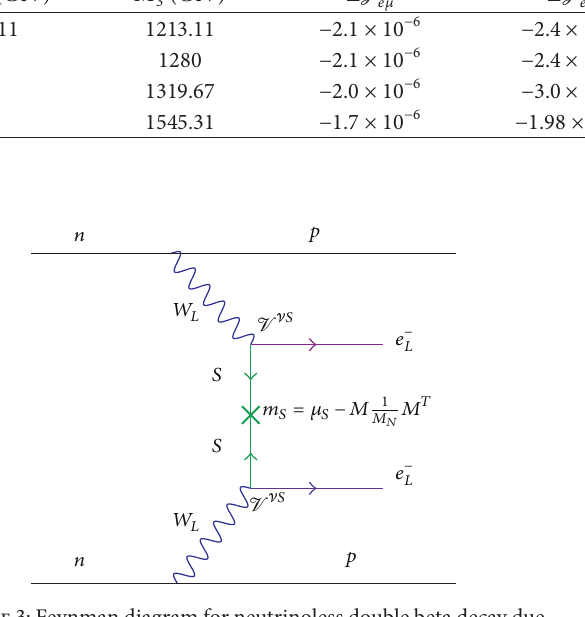
Figure 3: Feynman diagram for neutrinoless double beta decay due to exchange of light sterile neutrino 𝑆